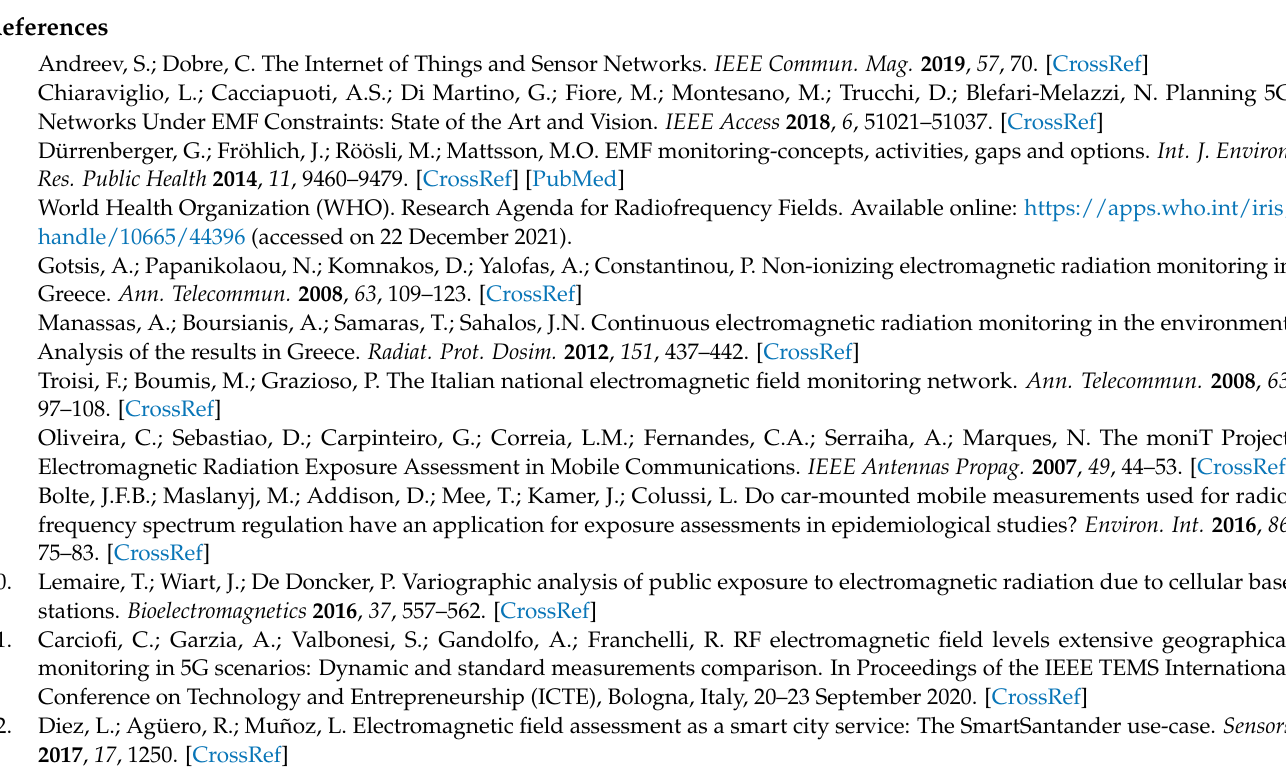
Figure A2. In situ validation results: ( a ) comparison of the fixed network sensors to a ground level (i.e., 1.5 m) SRM; ( b ) comparison of the network sensors to a ground level sensor; and ( c ) comparison of the ground level sensor to the ground level SRM.